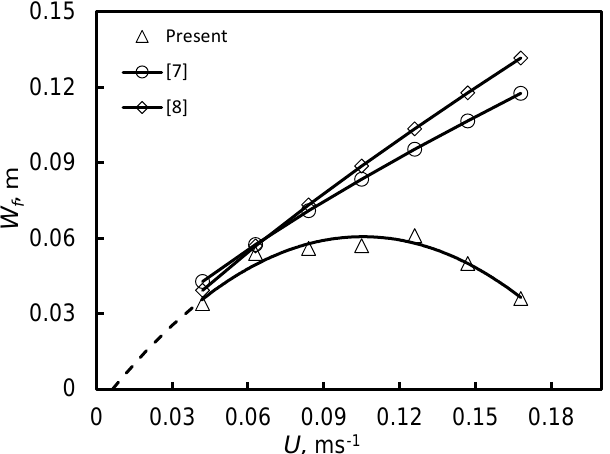
Figure 7. Comparison of W f with the models available in the literature.